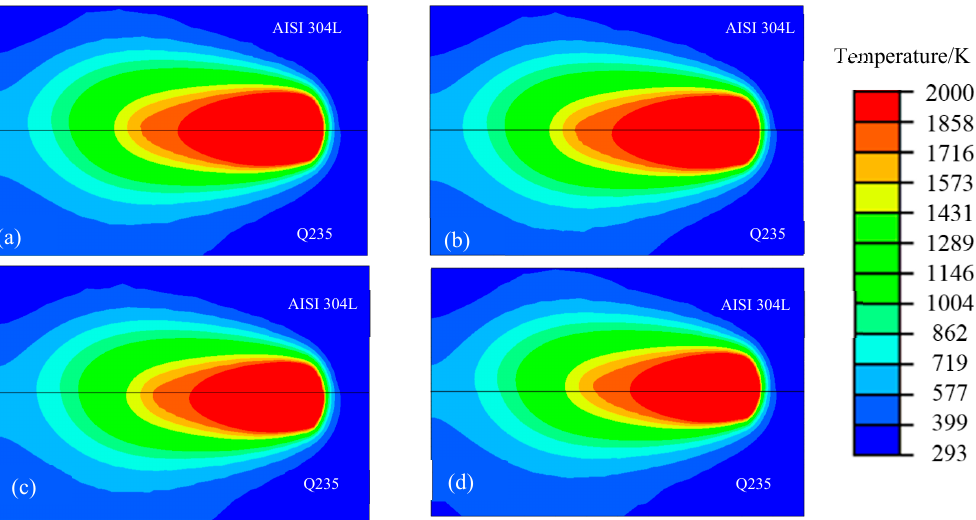
Figure 13. The top views of the simulation results: ( a ) laser beam offset = 0 mm; ( b ) laser beam offset = 1 mm; ( c ) laser beam offset = 1.5 mm; ( d ) laser beam offset = − 1 mm.